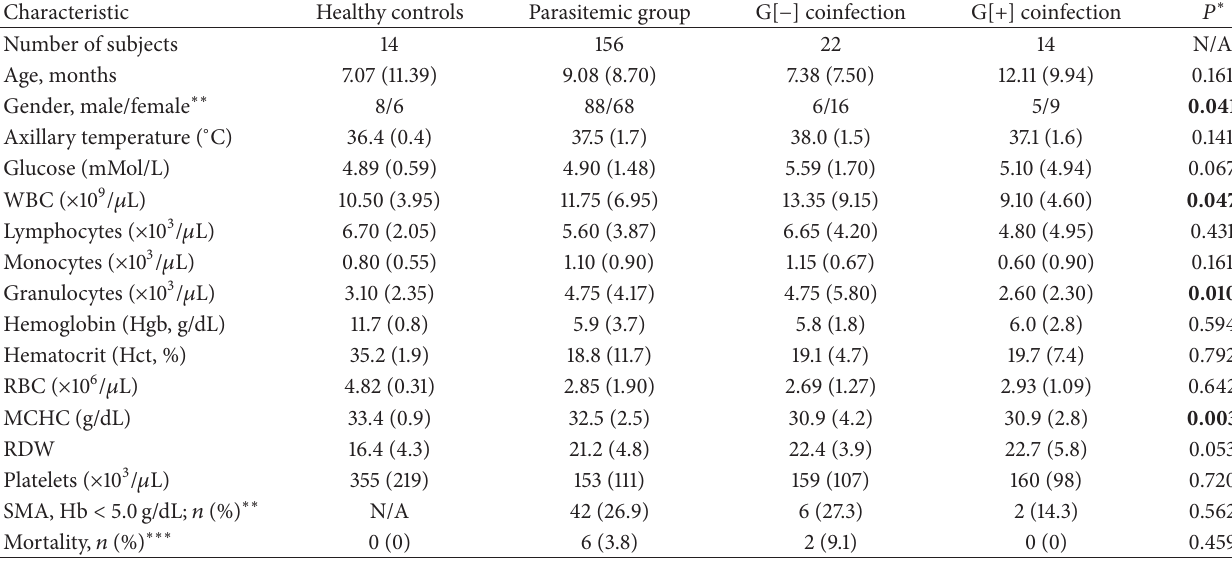
Table 2: Clinical, demographic, and hematological characteristics of the study